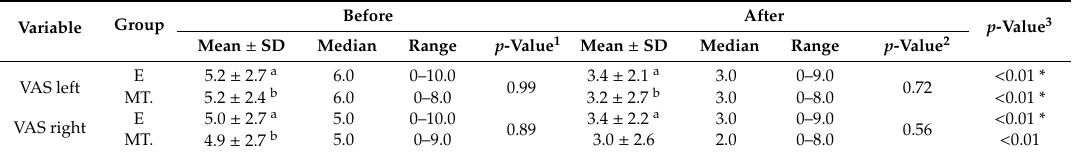
Table 4. Results of VAS scales in E, MT, and C groups of